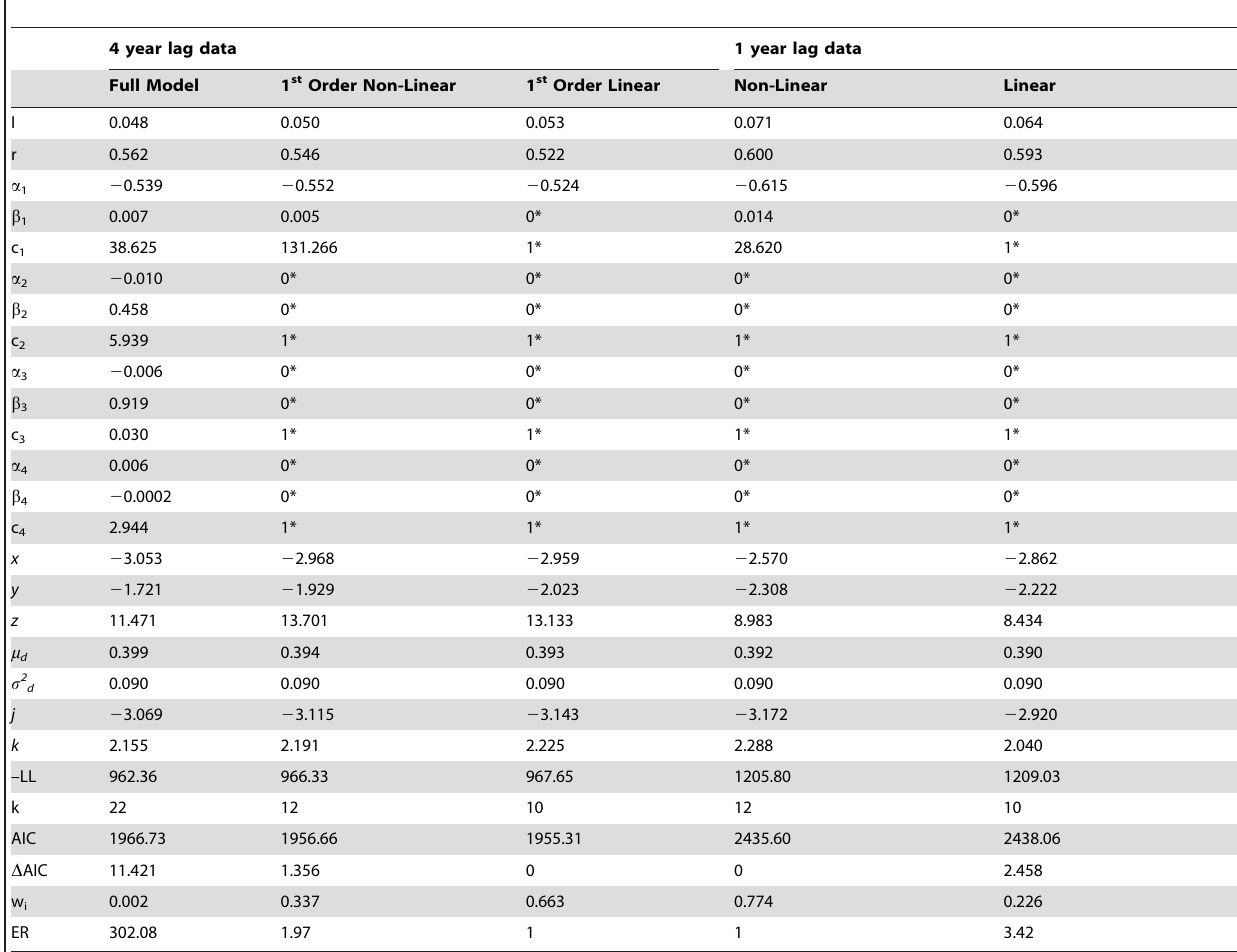
Table 2. Maximum likelihood estimates of parameters for linear and nonlinear models of mussel abundance dynamics with density-linked stochastic